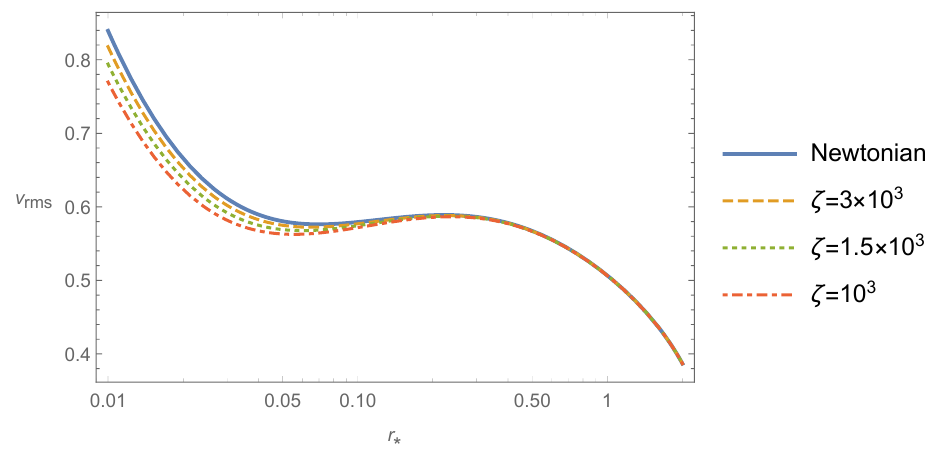
Figure 1. v rms as function of r ∗ for β = 0.1, µ = 0.004. Solid line corresponds to Newtonian solution and dashed lines to post-Newtonian solutions for ζ = 1.0 × 10 3 ;1.5 × 10 3 ;3.0 × 10 3 .